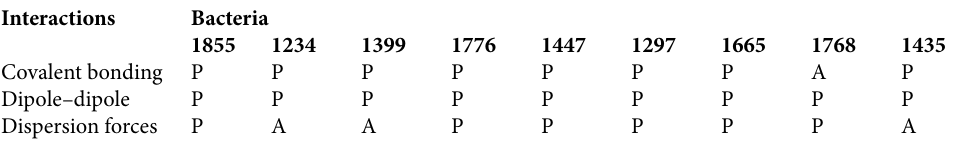
Table 6. The presence (P) or absence (A) of interactions contributing to QSAR calculations. Interactions